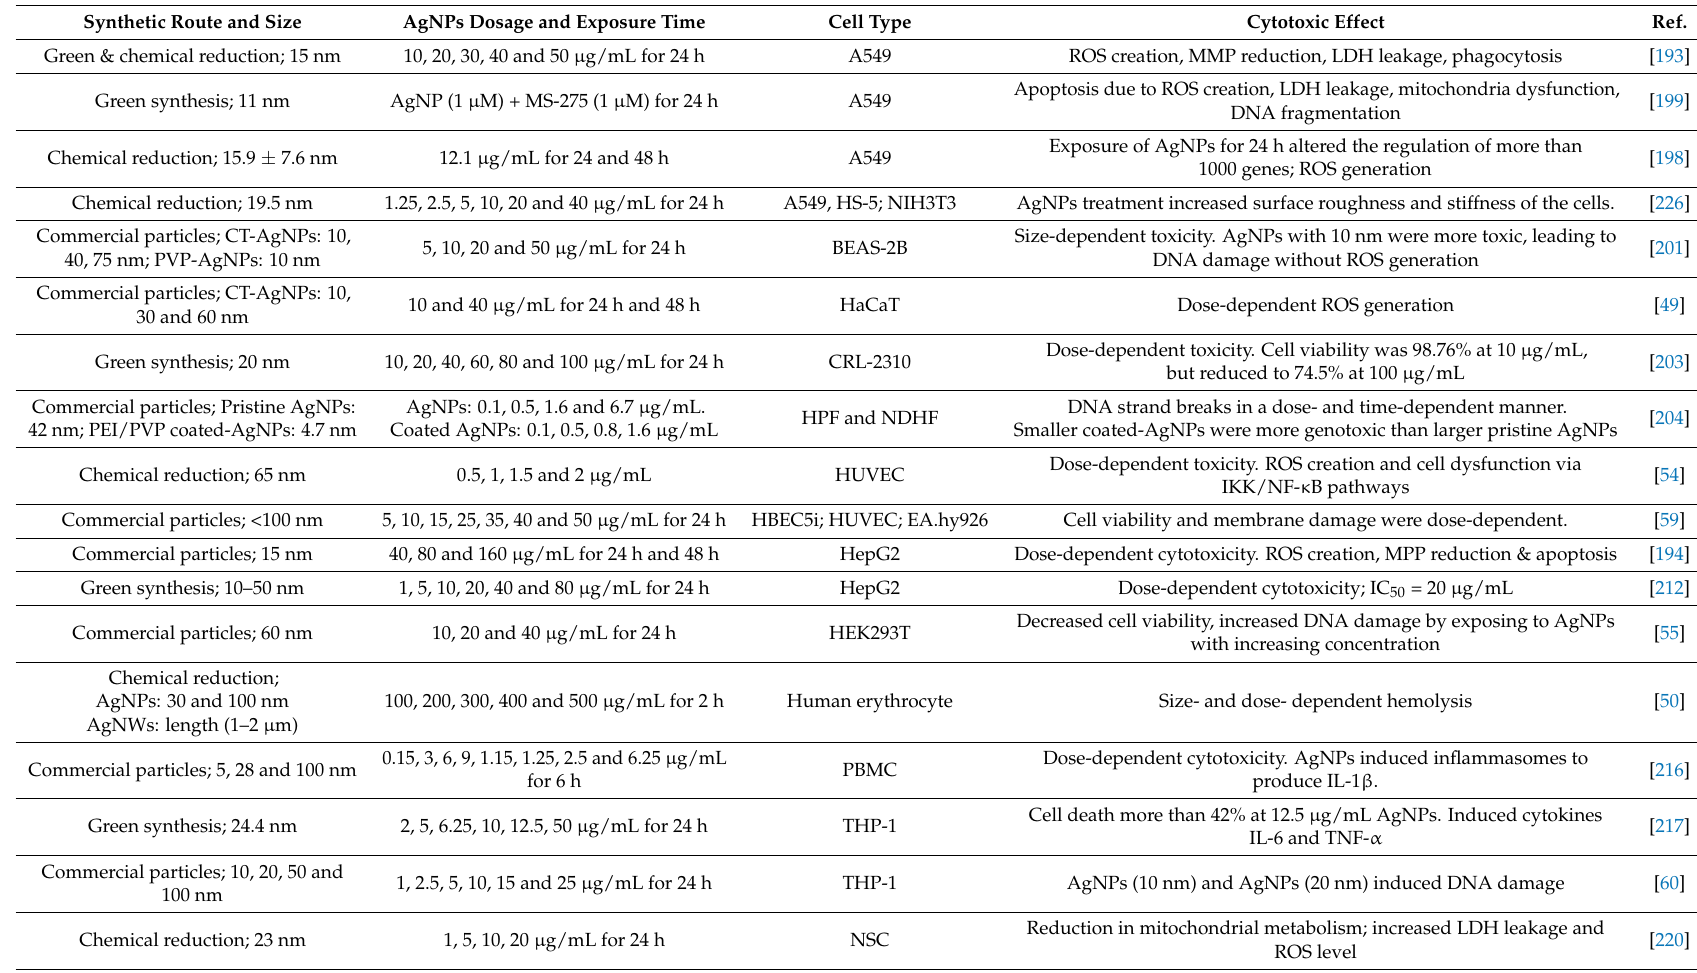
Table 2. Cytotoxic effects of AgNPs on human cell